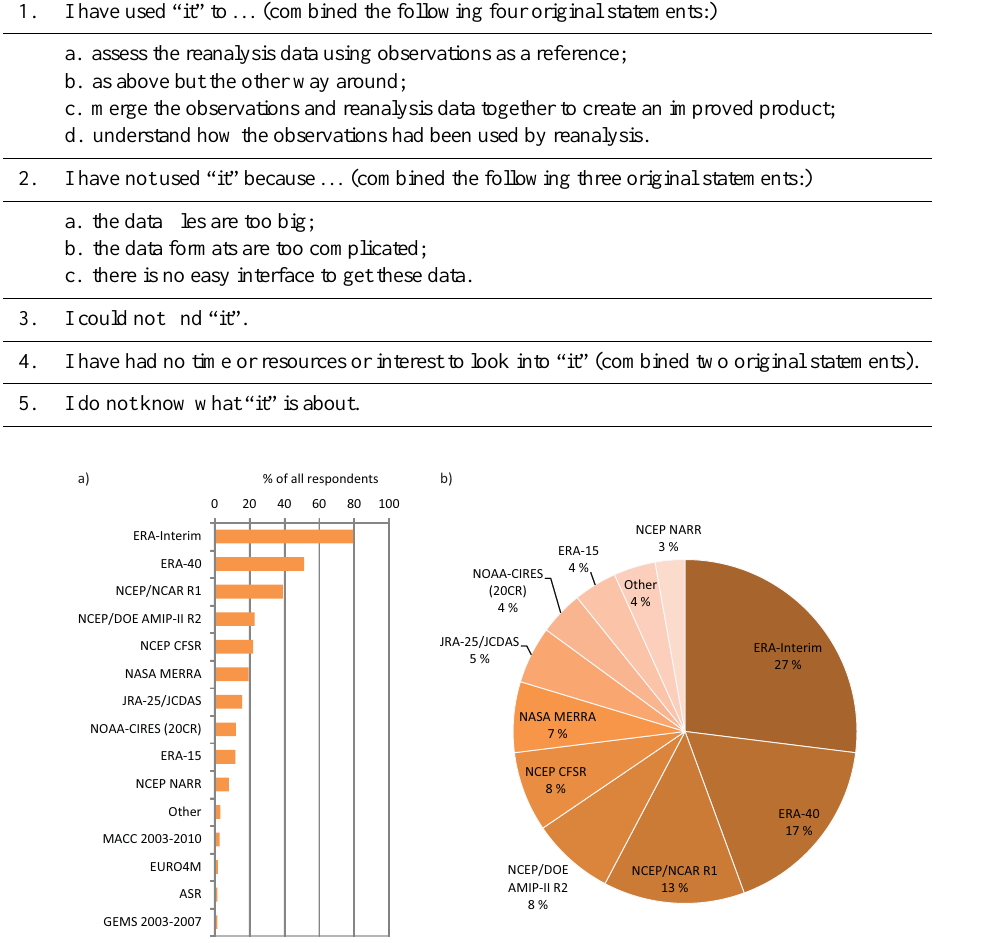
Figure 2. Atmospheric reanalysis data sets that the respondents most often used. (a) Percentages of all respondents (2502). (b) Percentages of all declared instances of atmospheric reanalysis use (7597) given by respondents. The sector “Other” includes the four least used reanalysis data sets as well as the option “other”. It was asked to choose all that apply.